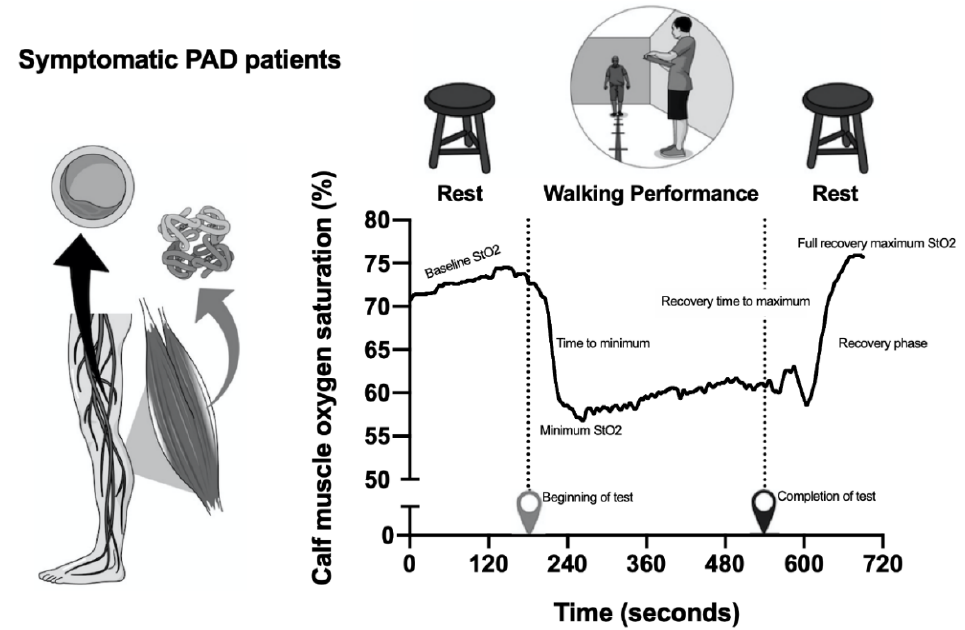
Figure 1. Calf muscle oxygen saturation (StO 2 ) parameters obtained before, during, and after the 6 min walk test (6MWT) test in symptomatic peripheral artery disease (PAD).